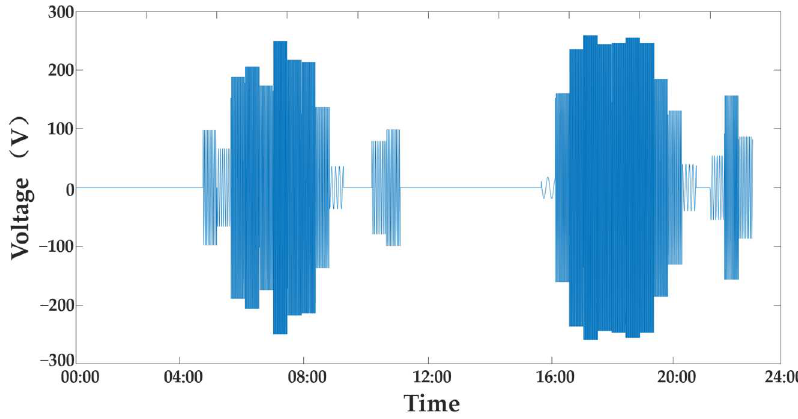
Figure 3. Daily variation pattern of tidal power generation electricity.